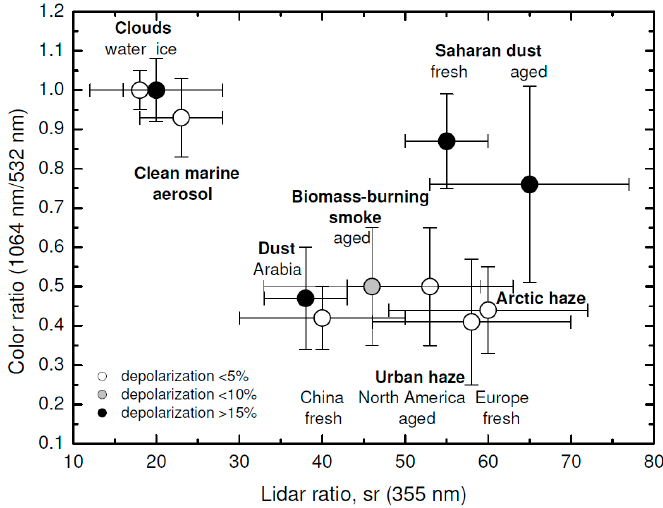
Figure 6. Color ratio vs. lidar ratio vs. depolarization ratio for different aerosol and cloud types [72] with data from [73].